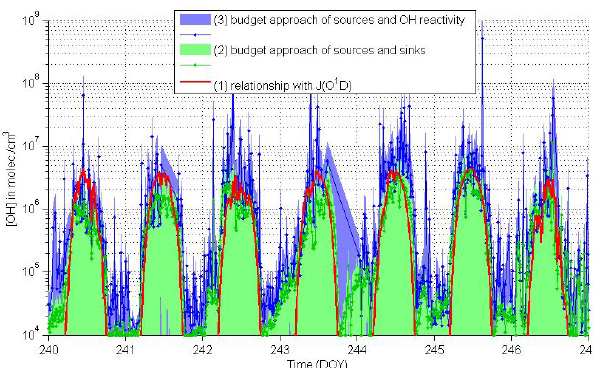
Figure 4. Concentrations of ambient OH calculated through dif- ferent approaches for a period during PARADE (DOY 240–247): (1) J( O 1 D ) -based formulation, (2) budget approach of measured individual sources and sinks as well as (3) budget approach of mea- sured individual sources and OH reactivity. The extended version can be found in the Supplement (Sect. B, Fig. S6, p.